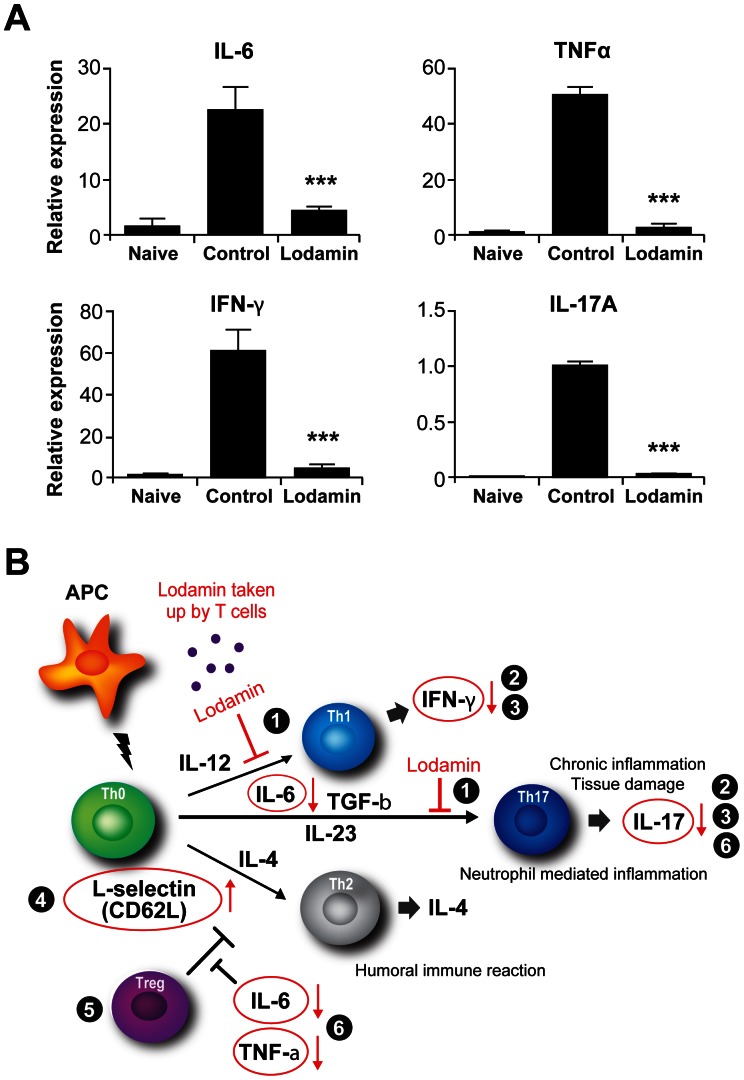
Reduced inflammatory cytokine expression in retina from Lodamin-administered mice, and summary of Lodamin’s activity on T cells.(A) On day 21 after IRBP immunization, retinas were harvested and total RNA was extracted from naive mice (unimmunized control), EAU control group and Lodamin-administered group. The expression of IL-6, TNF, IFN-γ, and IL-17A were analyzed by realtime qPCR (mean ± SEM, n = 5–8, ***p<0.001). (B) Summary of Lodamin’s effects on T cell activity and differentiation in vitro and in EAU model (circled, red): Lodamin is taken up by T cells and (1) suppress the activation and differentiation of CD4+ T cells to Th1 and Th17. (2) reduces production of IL-17 and IFNγ in splenocytes and activated T cells (3) reduces IFNγ and IL-17 in Lymph T cells from EAU mice (4) increases the expression of homing receptor CD62 lymph node CD4+ T cells (5) do not effect Treg proliferation in lymph nodes (6) reduces the expression of retinal cytokines: IL-6. TNFα, IFNγ, IL-17A.